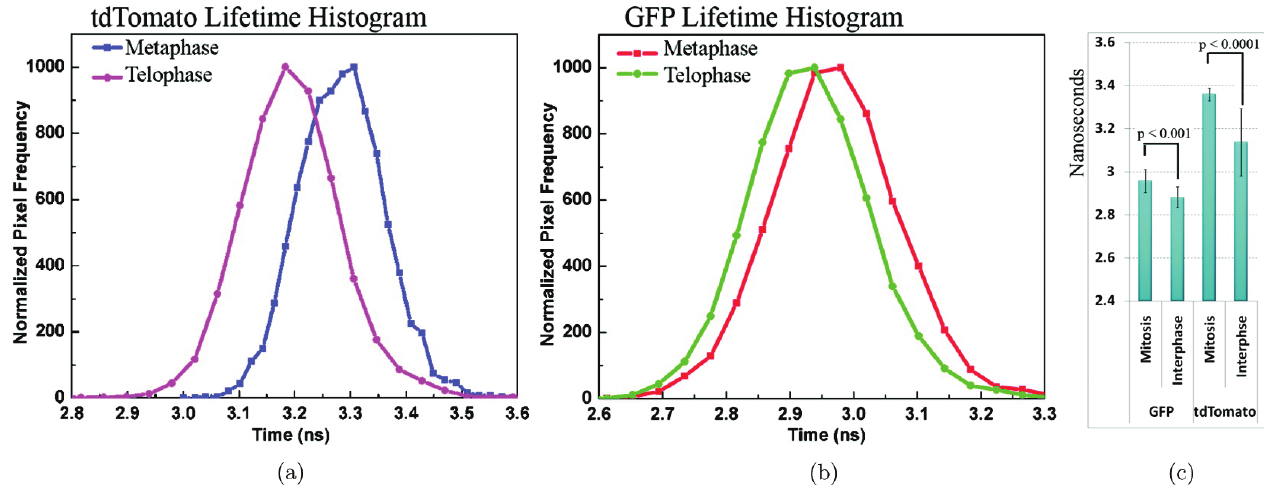
Fig. 3. Alteration of °uorescence lifetime distributions of (a) td Tomato and (b) GFP in cells during the transition from mitosis to interphase. (c) The statistical analysis of °uorescence lifetimes measured in interphase cells nuclei and in mitotic